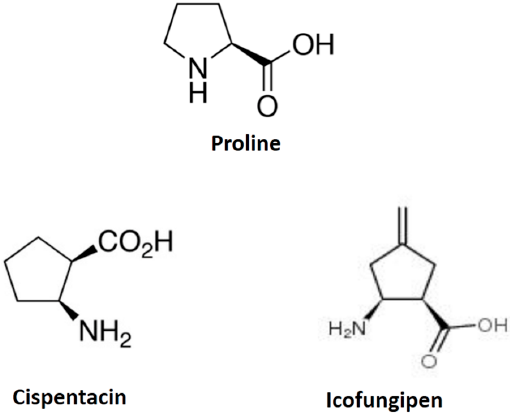
Figure 1. Comparative structures of proline, cispentacin, and icofungipen.